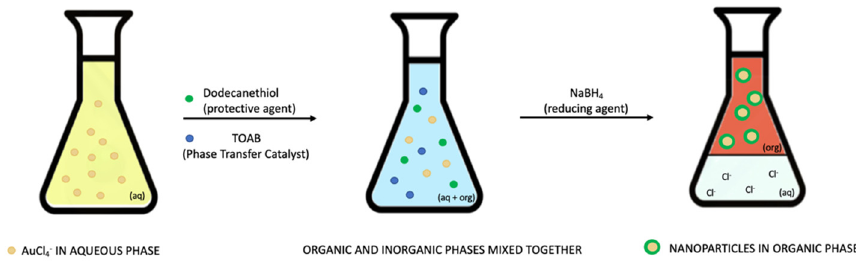
Scheme 3. Scheme of phase-transfer NP synthesis.